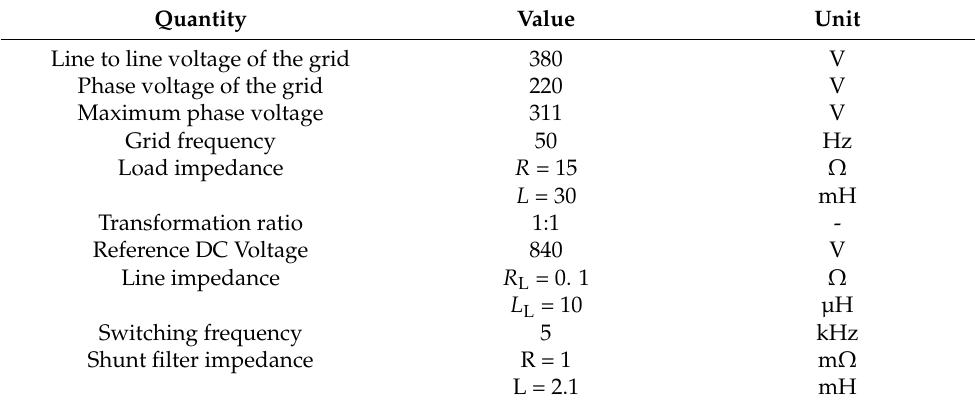
Table 3. The parameters of the system.